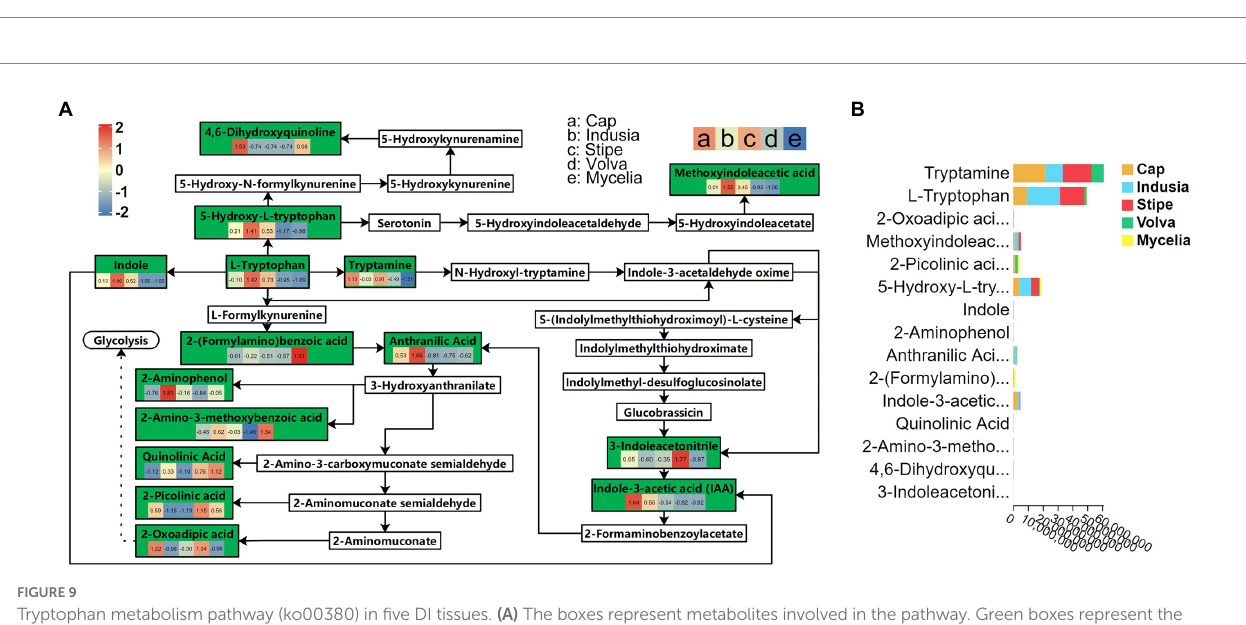
pathway. NR database-based annotation showed that most DEGs were